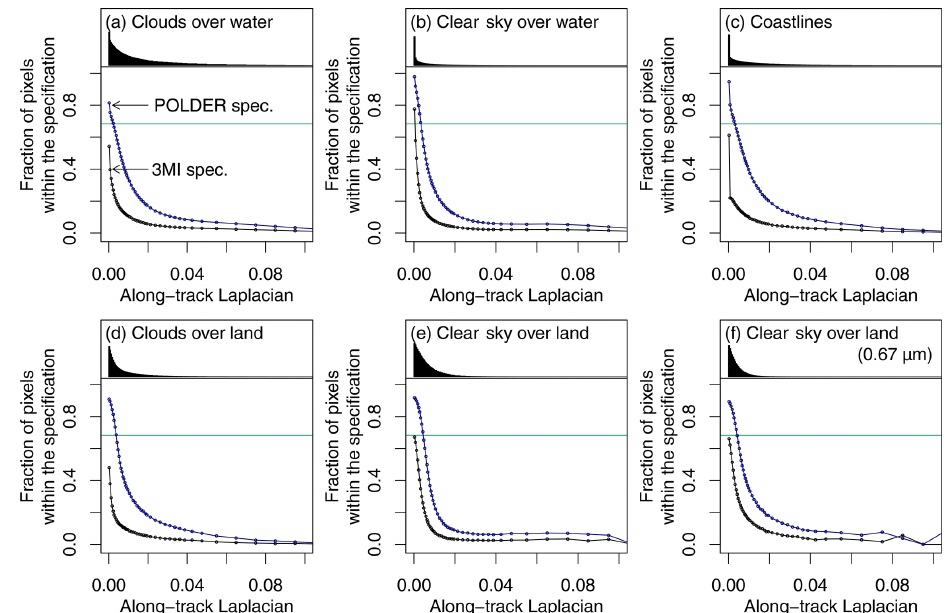
Figure 8. The fraction of pixels within the POLDER specification (blue) and the 3MI specification (black) in each bin of along-track Laplacian. The six panels are for (a) clouds over water, (b) clear sky over water, (c) coastlines, (d) clouds over land, (e) clear sky over land, and (f) clear sky over land at 0.674µm. The density histograms of the along-track Laplacian are presented on the top of each panel. The green horizonal line shows the fraction of 0.682, which corresponds to the fraction of data within 1 σ of a normal distribution.